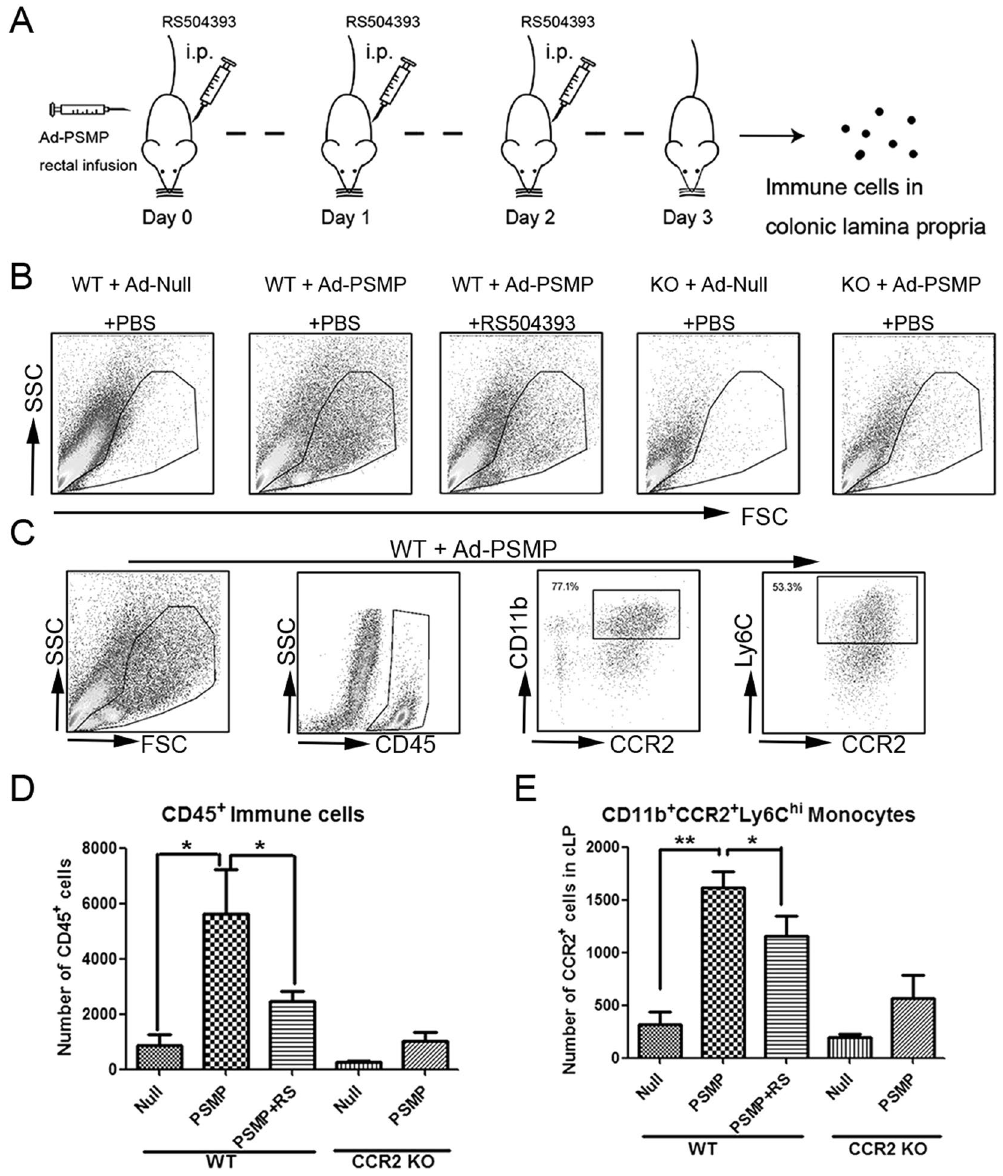
Figure 4. PSMP expression in situ in the colon chemo-attracted Ly6C hi CCR2 + monocytes in a CCR2- dependent manner. ( A ) After the wild type or CCR2 KO mice colons were infected with Ad-Null or Ad-PSMP in situ for 72 h, respectively, the immune cells that had infiltrated the lamina propria of the Ad-Null group, Ad-PSMP group and RS504393-treated Ad-PSMP group were detected by flow cytometry; And RS504393 was administrated by i . p . at the indicated time. ( B ) The immune cells infiltrated into the lamina propria of the five groups were analyzed by flow cytometry. ( C ) The main subset of the infiltrated immune cells in the Ad-PSMP wild type mice was analyzed by flow cytometry with the antibodies for CD45, CD11b, CCR2 and Ly6C, and the percentages of the CD11b + CCR2 + cells and CD11b + CCR2 + Ly6C hi cells among the total immune cells (CD45 + ) were quantified. ( D ) and ( E ) The total immune cell (CD45 + ) and monocyte (CD11b + CCR2 + Ly6C hi ) infiltrations in the lamina propria of the five groups were statistically analyzed. Data were representative of at least three independent experiments with five mice per group. * 0.01 < p < 0.05, ** 0.001 < p < 0.01, and *** p <